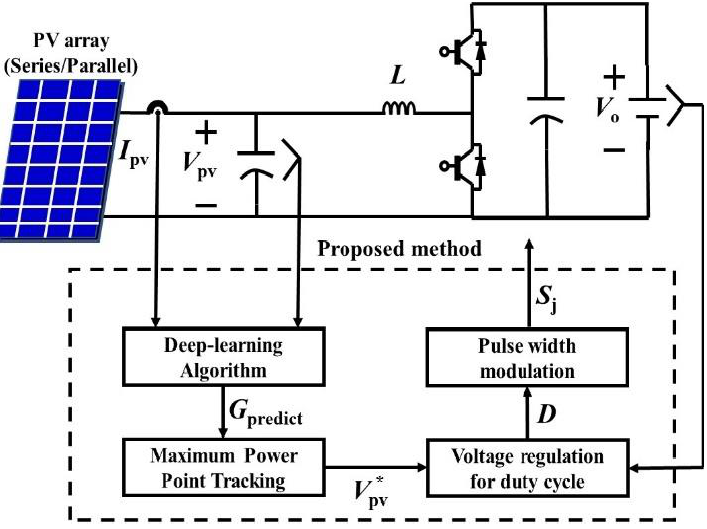
Figure 4. Block diagram of the proposed control algorithm for solar power generation.